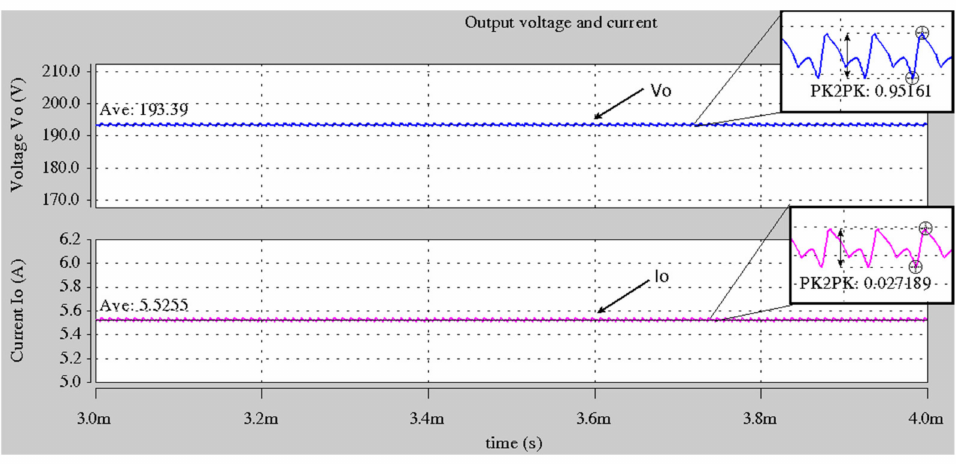
Figure 8. Simulation results for V o and I o